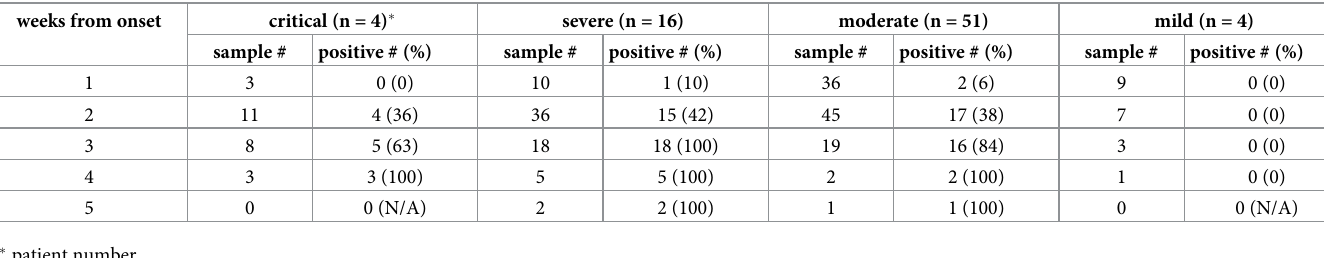
Table 3. Clinical sensitivity of VITROS